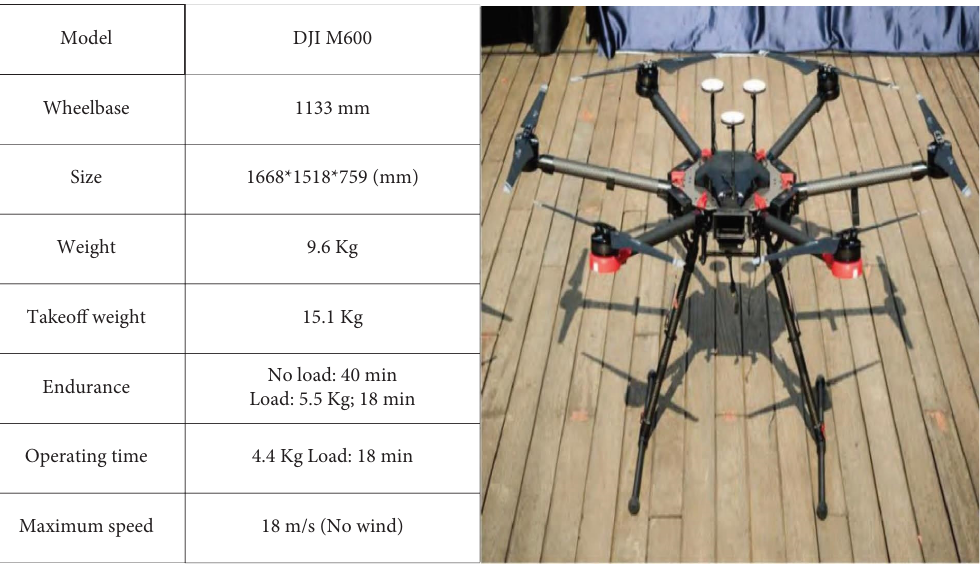
Figure 4: Basic technical parameters of the mapping